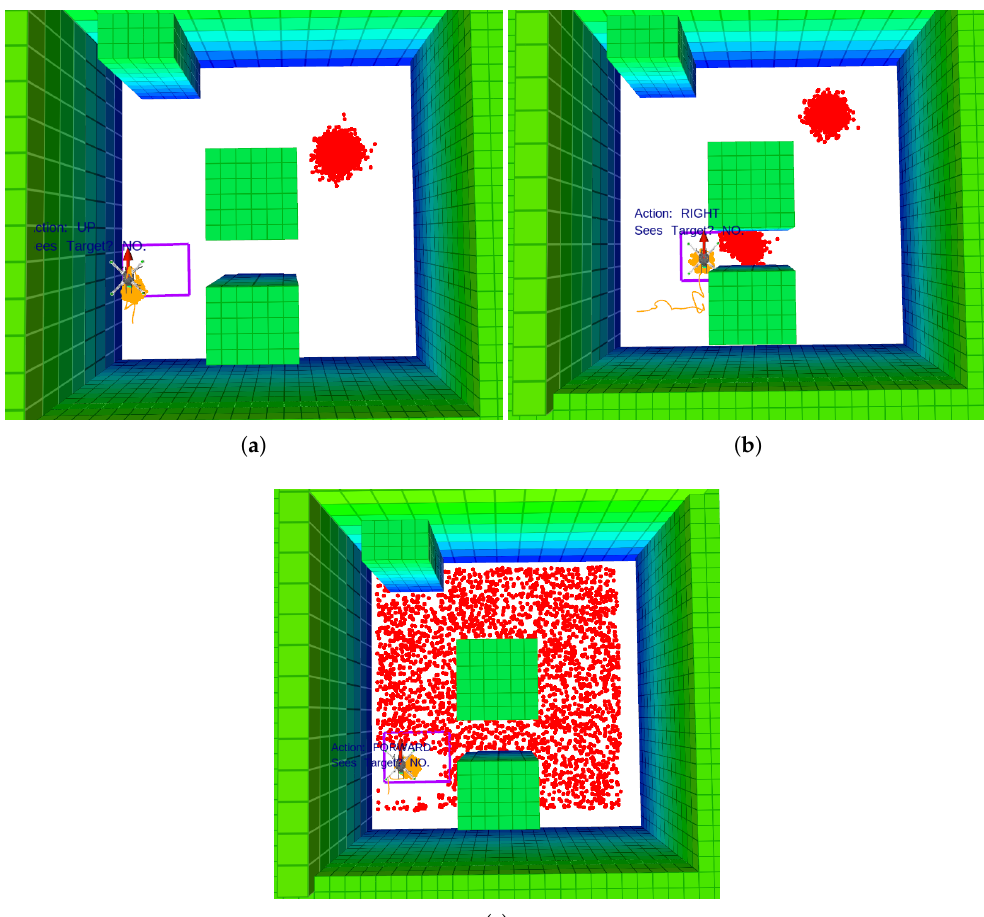
Figure 9. Tested case studies of search and rescue situational awareness regarding the victim location. Orange splines represent the path of the UAV; green blocks are the environment obstacles; the orange point-cloud is the UAV position belief; the red point-cloud is the victim position belief; and the purple rectangle the camera’s Field of View (FOV). ( a ) Victim position points distributed in a single cluster. ( b ) Victim position points distributed in two clusters. ( c ) Cluster of victim position points uniformly distributed along the flying